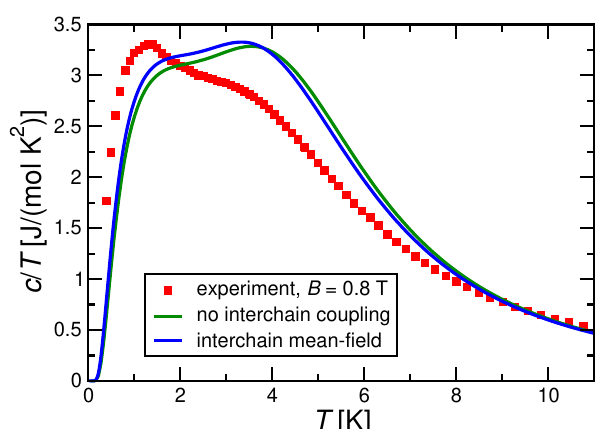
Figure 11. Magnetic specific heat per spin divided by temperature c / T for J = 2.8 K, D = 0.36 K in a magnetic field h = 0.4 J in comparison with the experimental results for B = 0.8 T. Theoretical results are obtained by ED with N = 10 both for decoupled chains ( J ⊥ = 0) and with a self-consistent mean-field treatment for J ⊥ = 0.072